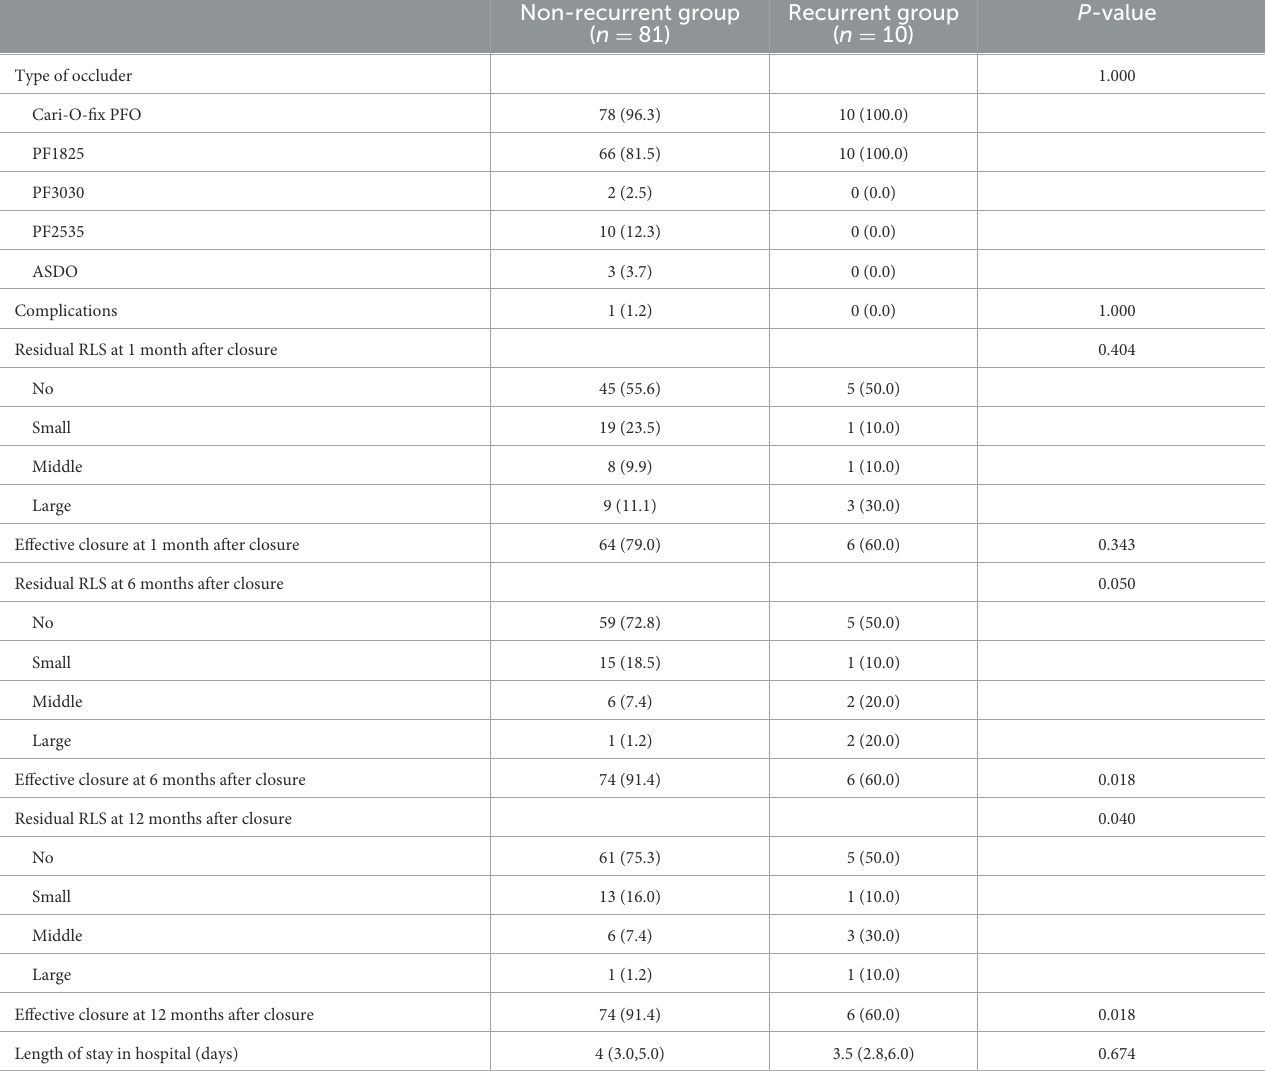
TABLE 4 Comparisons of operation and follow-up between the non-recurrent group and the recurrent group.